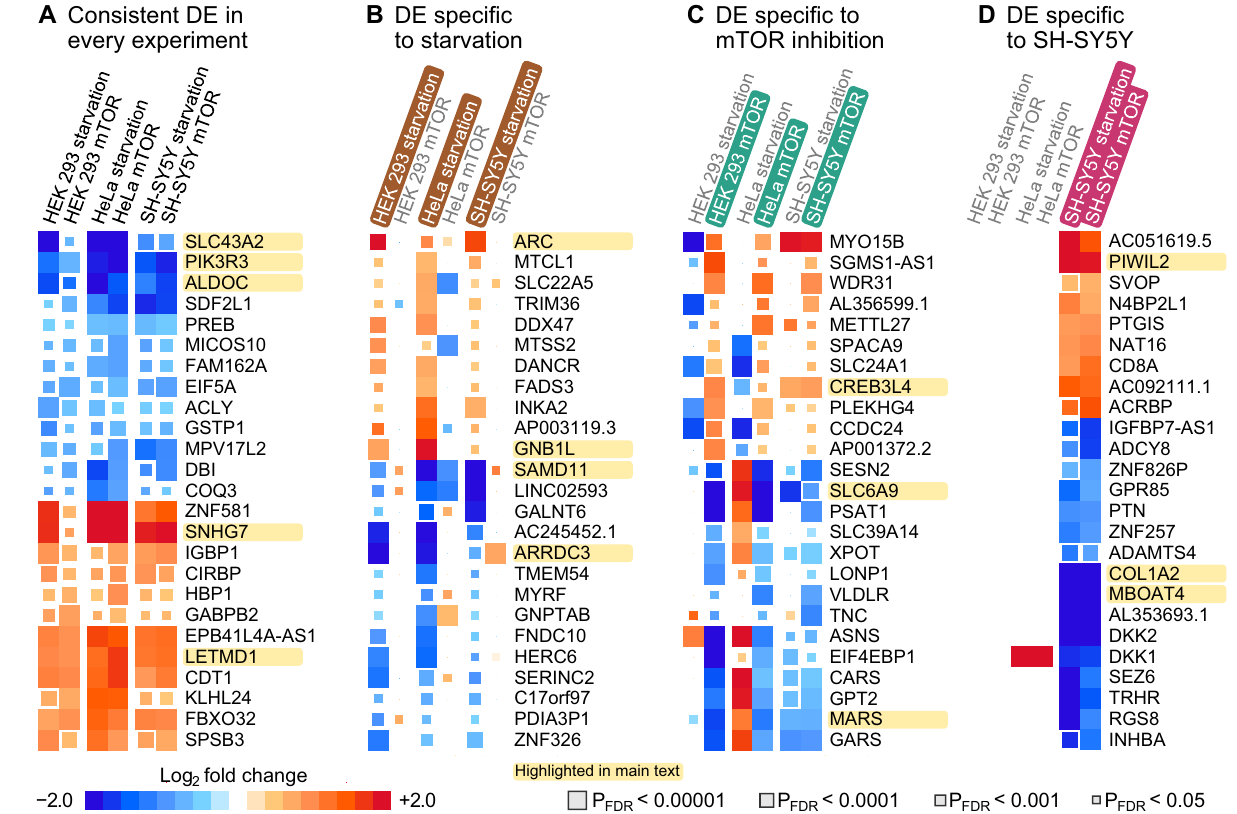
Figure 2. Top 25 differentially expressed (DE) genes based on the maximum FDR rule. Genes mentioned in the main text are highlighted for easier visual localization. ( A ) Genes were sorted according to the maximum FDR-adjusted P-value across six experiments. Discordant genes that were significantly (P FDR < 5%) up-regulated in one and down-regulated in another experiment were excluded. ( B ) Genes were sorted according to the maximum P FDR across all starvation experiments. We also required that all starvation responses were directionally concordant and that the mean log 2 fold change across mTOR experiments was in the opposite direction. ( C ) Genes were sorted according to the maximum P FDR across all mTOR inhibition experiments. We required that all mTOR inhibition responses were directionally concordant and that the mean log 2 fold change across starvation experiments was in the opposite direction. ( D ) Genes were sorted according to the maximum P FDR across responses in the SH-SY5Y cells. Missing signals were set to zero log 2 fold change in other cell lines. We also required that the mean log 2 fold changes in other cells were in the opposite direction to SH-SY5Y